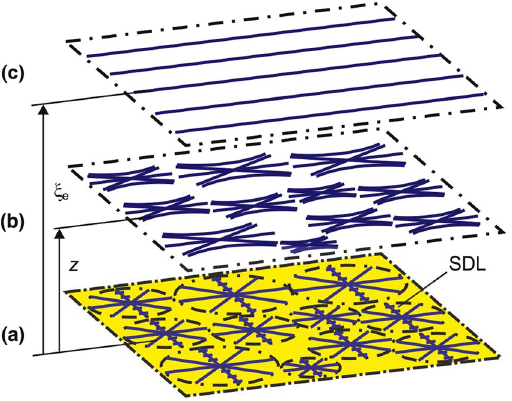
Figure 5. Schematic of the radial-planar structure: on polycarbonate surface. ( a ) At the PC film; ( b ) at a distance z from the surface; ( c ) at equilibrium length ξ e